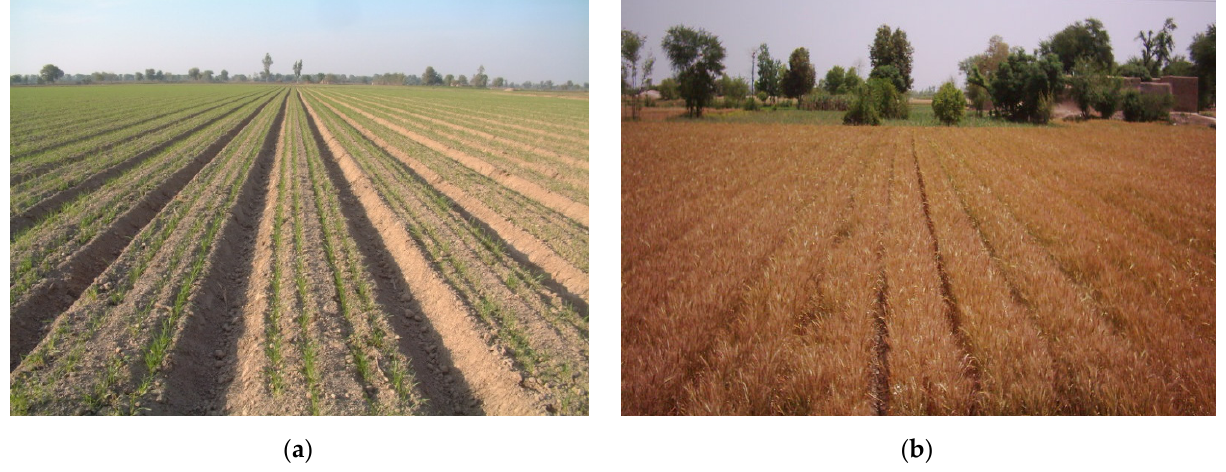
Figure 1. Different phases of wheat planting on beds at farmers’ fields under UAF technology transfer program. ( a ) Wheat right after germination on beds; ( b ) wheat at full maturity right before harvesting.